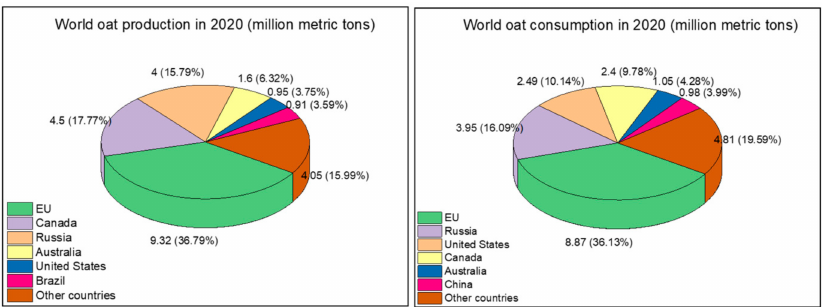
Figure 1. World production and consumption of